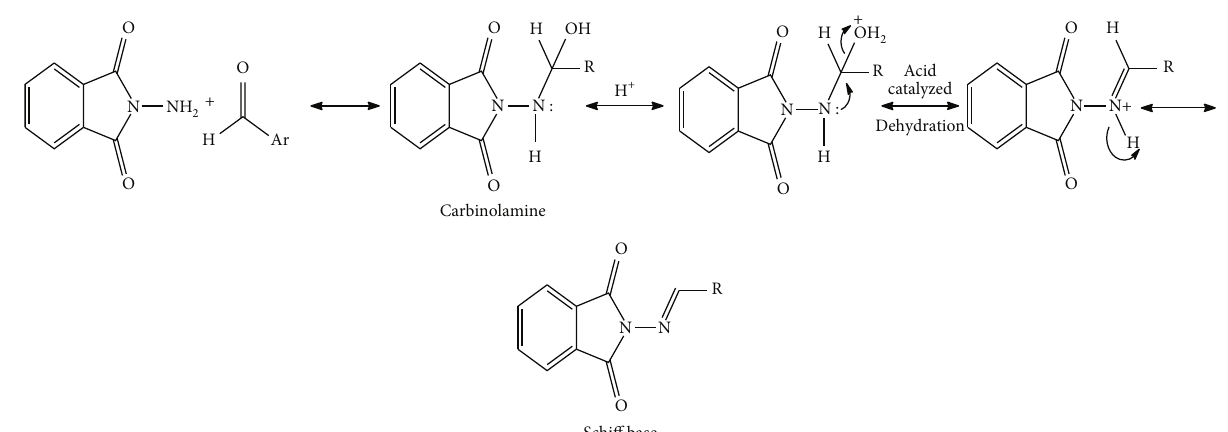
Figure 2: Reaction mechanism for N-aminophthalimide derivatives